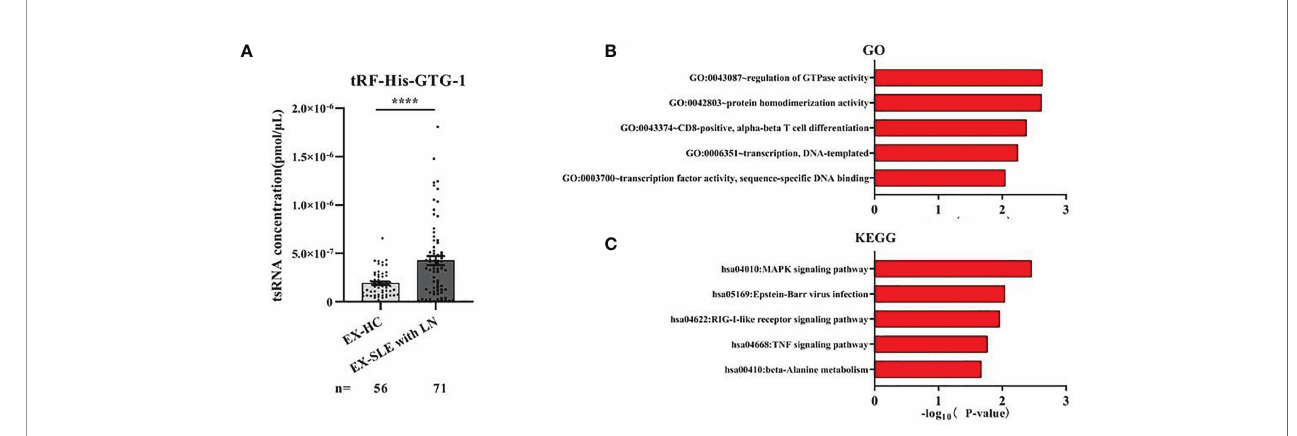
FIGURE 5 | The biological functions of the tRF-His-GTG-1. (A) Expression analysis of tRF-His-GTG-1 in exosomes of healthy group and systemic lupus erythematosus (SLE) group. Statistical signi fi cance was determined by unpaired two-tailed t-test (****P < 0.0001). (B) Gene Ontology (GO) term analysis of tRF-His- GTG-1. (C) Kyoto Encyclopedia of Genes and Genomes (KEGG) signal pathway analysis of tRF-His-GTG-1.